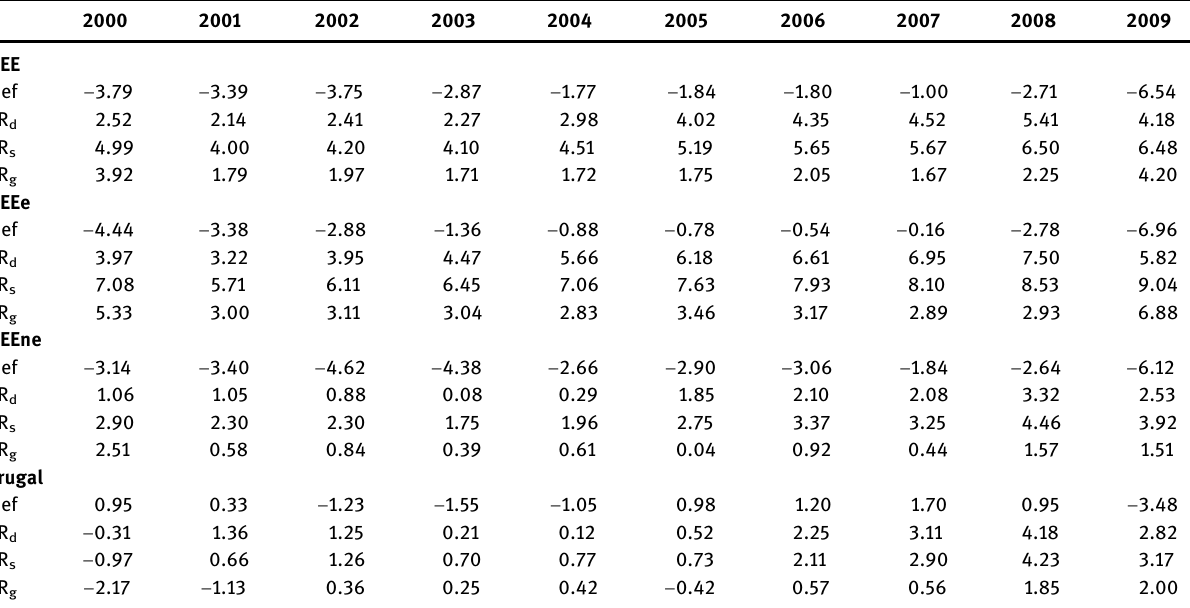
Table 2C: Government de fi cit ( − ) /surplus (+) , 2000 – 2009, ψ =